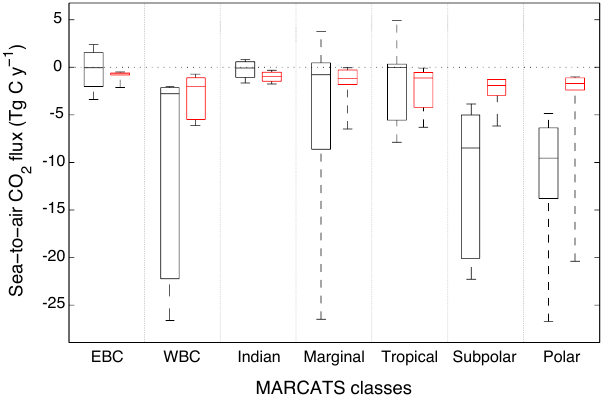
Figure 7. Box plots of the simulated sea-to-air CO 2 fluxes (TgCyr − 1 ) grouped into the MARCATS classes of the coastal ocean. Black boxes indicate total fluxes, and red boxes indicate an- thropogenic fluxes. Shown are the lowest estimate, the first quar- tile, the median, the third quartile, and the highest estimate for each